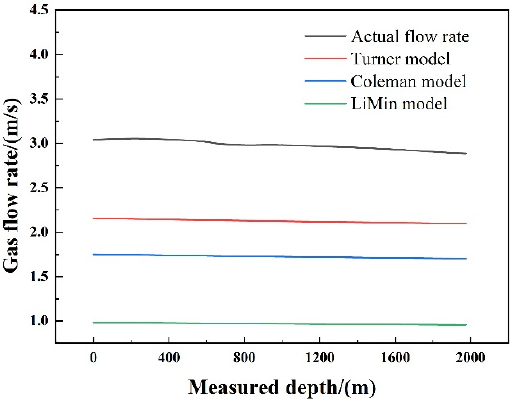
Figure 1. Actual flow rates and liquid-carrying flow rates in the vertical part of the well.